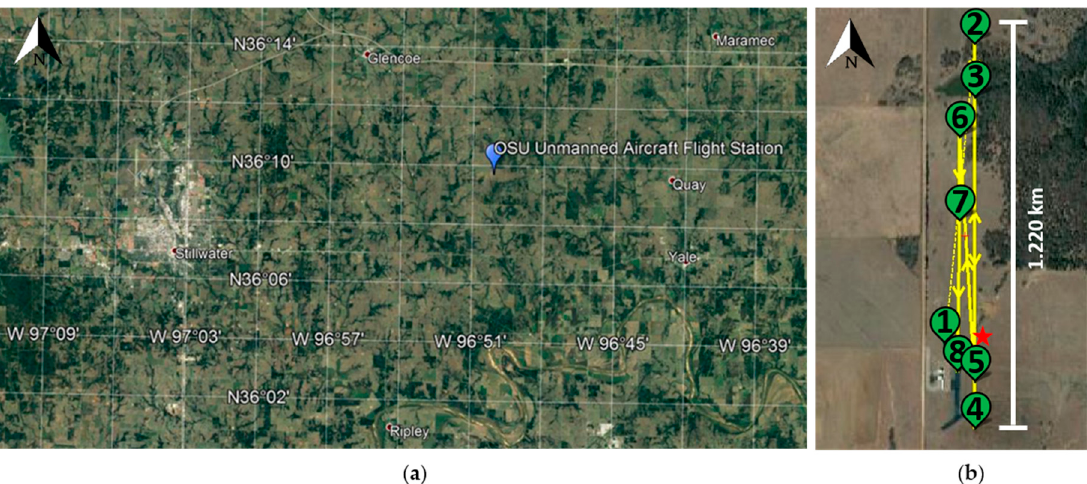
Figure 1. ( a ) A regional map indicating with a blue pin the flight campaign location. For reference, the grid lines defined by latitude and longitude have a length of ~4.5 km. ( b ) An aerial photo of the Unmanned Aircraft Flight Station with the distance flown by the Skywalker X8 aircraft. The green pins show the horizontal flight pattern connected by yellow arrowed lines following the progression of numbers covered by the Skywalker X8. The red star indicates the fixed coordinates for vertical profiles registered with the DJI Phantom 3 (DJI P3) quadcopter.